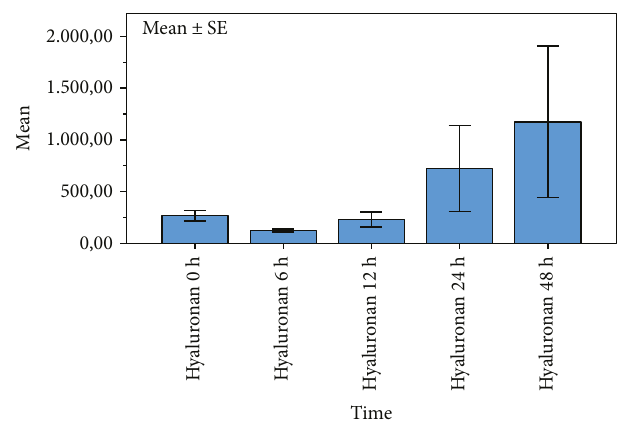
Figure 2: Serum levels of hyaluronan within 48 h after out-of-hospital cardiac arrest. Signi fi cant increase of hyaluronan levels within 48h after resuscitation; bars represent mean values with error bars representing ± 1 SE. MANOVA analysis for repeated measurements; p = 0 043 .